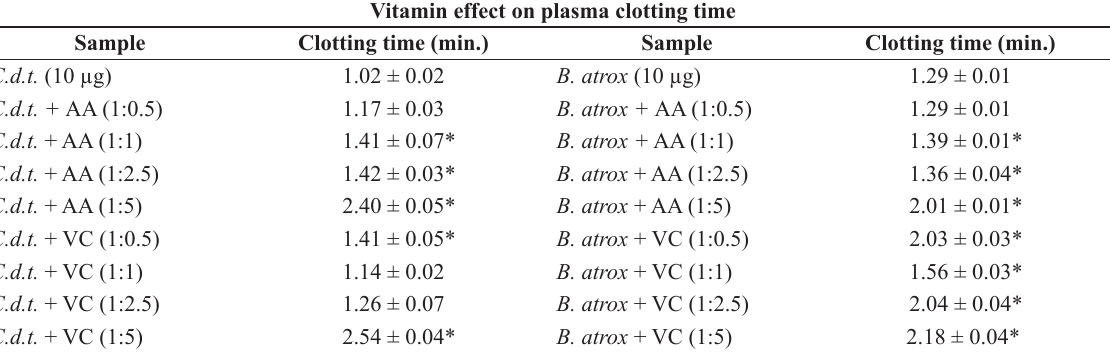
Clotting activity induced by Crotalus durissus terrificus and Bothrops atrox venom on human citrated plasma proceeding with preincubation of vitamins with the venoms in different ratios (for 5 min. at 37°C).